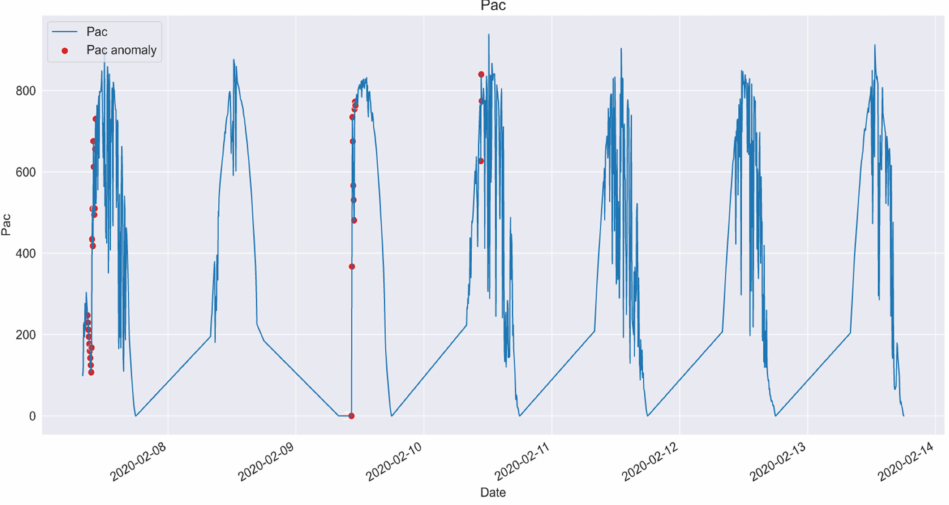
Figure 3. Anomalies detected by the proposed model using the second method in Power AC